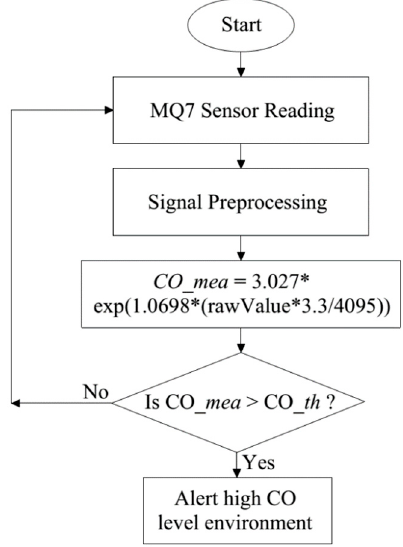
Figure 9. The high CO level alerting algorithm.